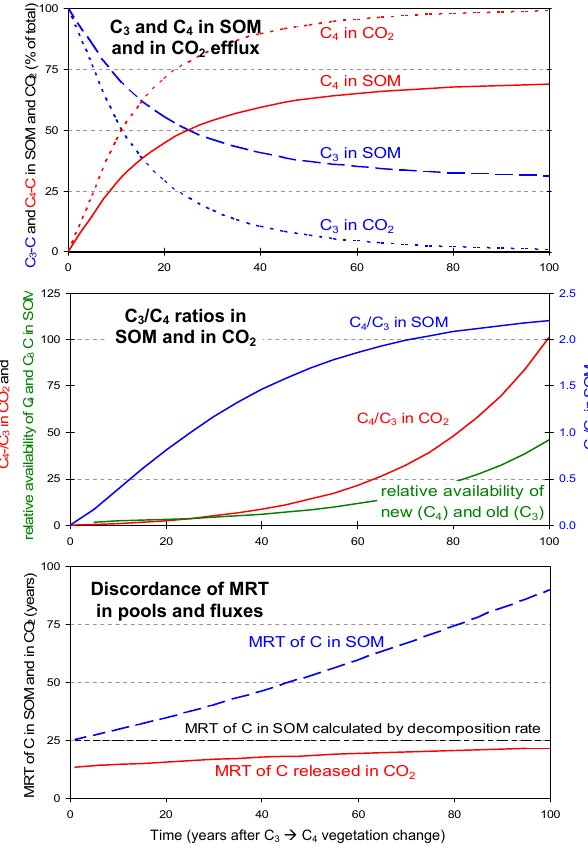
Fig. 5. Dynamics of C 3 and C 4 carbon in SOM and in CO 2 efflux (top) and the C 4 /C 3 ratio in SOM and in CO 2 as well as relative availability of old (C 3 ) and new (C 4 ) carbon (middle), and the mean residence time (MRT) of C in SOM and in CO 2 (bottom) after C 3 → C 4 vegetation change (steady state of total SOM is as- sumed). Note very low contribution of C 3 -C to CO 2 efflux after about 50yr despite it portion in SOM remains more than one third (top). The relative availability of old and new C is explained in text (see Sect. 3.2.1). The MRT of C was calculated based C 4 percent- age in SOM and in CO 2 according to Balesdent and Mariotti (1996) and Dorodnikov et al. (2011). The MRT of C in SOM calculated by decomposition rate (MRT=1/ k) is presented for comparison (bot-